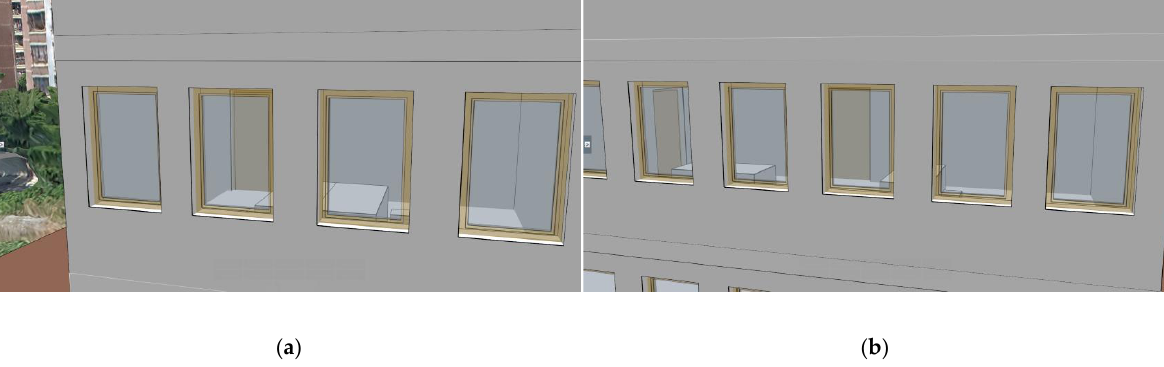
Figure 13. Results of the proposed method. ( a ) Area 1 and ( b ) area 2 of Figure 11. When loading the interior entities inside the model at a close distance, our method inevitably increases the geometric data compared with the Liu et al. (2016) method. However, only entities associated with the portal are loaded, and the volume of increased geometry is limited (Table 4). Table 4. Statistical results for the experimental test.